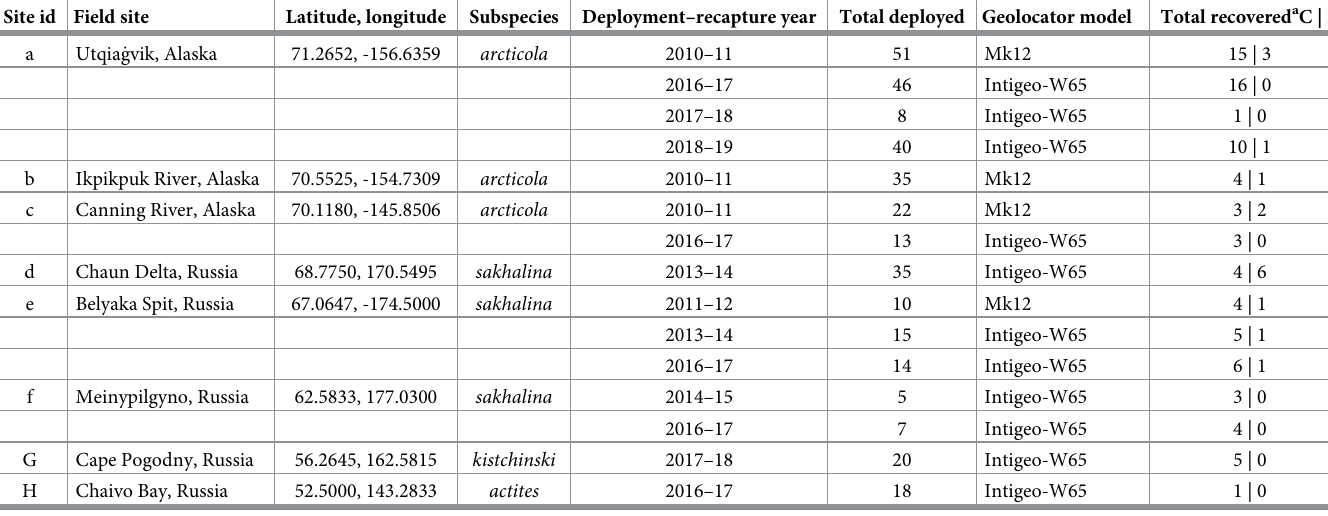
Table 1. Location, subspecies, and number of Dunlin equipped and later recaptured with light-level geolocators at 8 field sites along the East Asian-Australasian Flyway. Site locations are in Fig 1. Site id Field